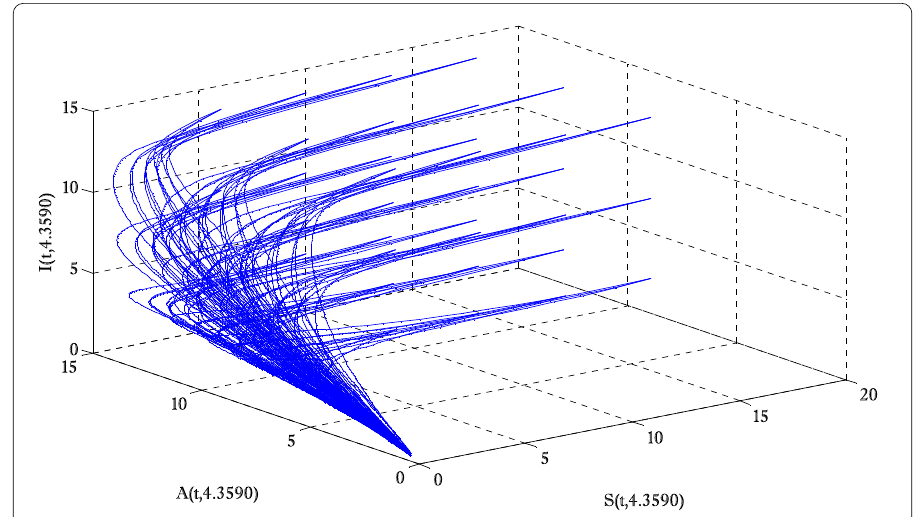
Figure 11 Three dimensional phase portrait of susceptible, asymptomatic and infected individuals